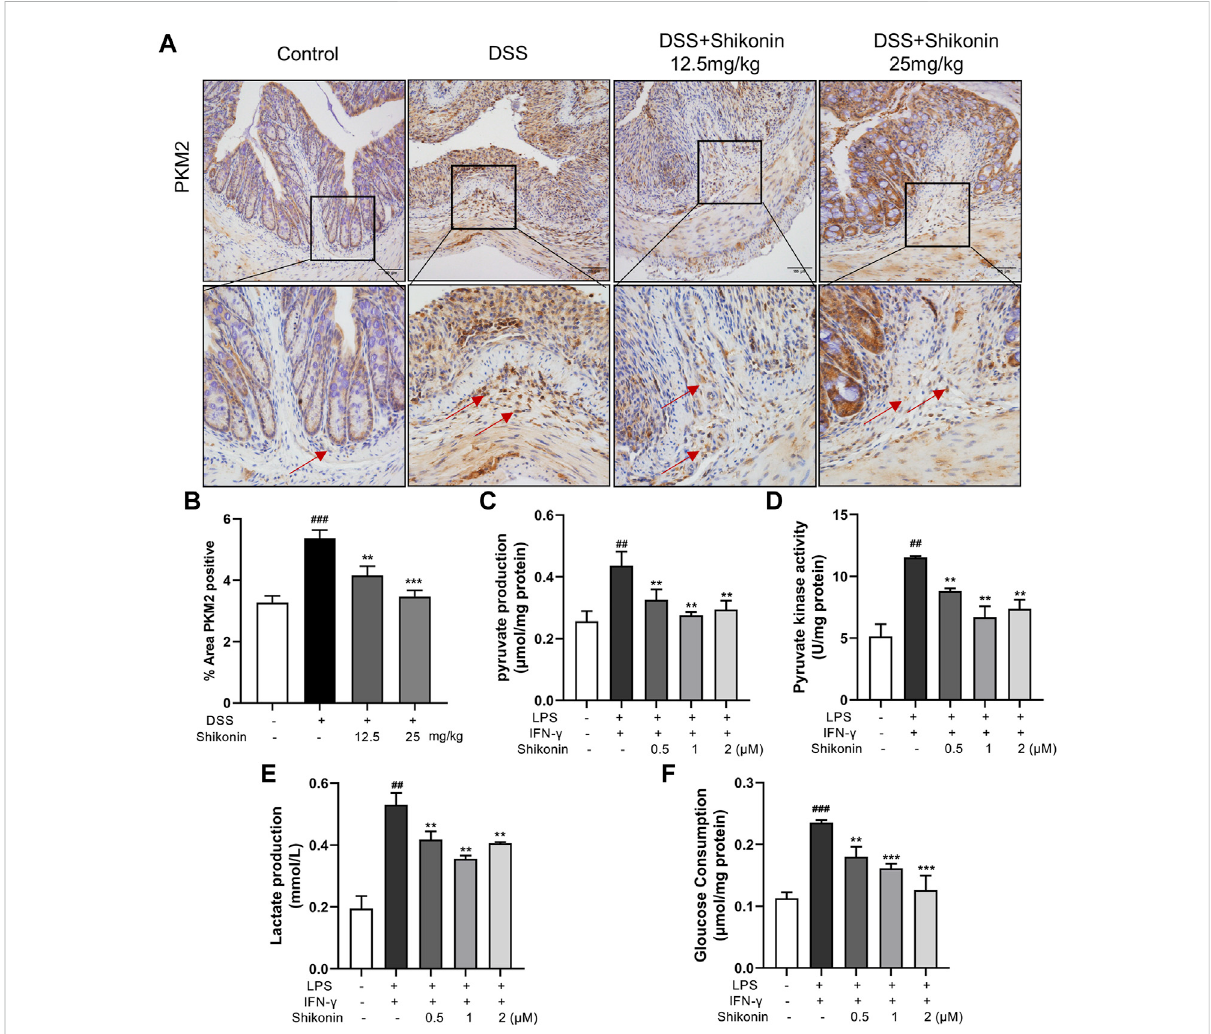
FIGURE 4 ShikonininhibitedPKM2 invivo anditsenzymaticpyruvatekinaseactivityandlactateproductioninRAW264.7cells.ExpressionofPKM2incolon of colitis mice was detected by immunohistochemistry assay (A) with statistics (B) . Pyruvate production (C) , pyruvate kinase activity (D) , lactate production (E) and gloucose consumption (F) were measured in Raw264.7 cells. Data are shown as the mean ± SD, n = 6 in Figure 4A, and n = 3